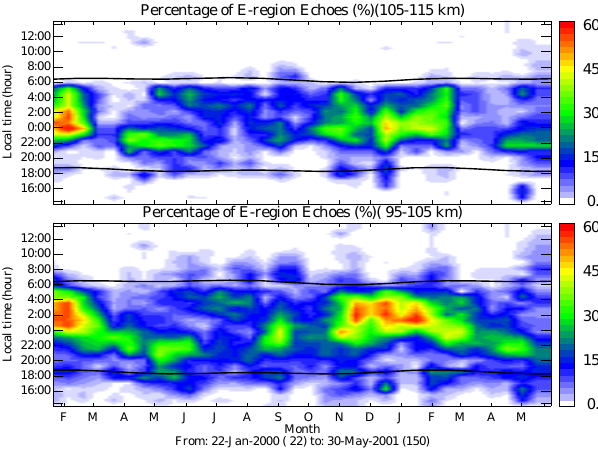
Fig.6. Seasonal variability of the diurnal percentage of occurrence of lower E-region (bottom) and the upper E-region (top) irregular- ities. These statistics have been obtained by processing 15 days at the time. The local sunrise (sunset) times are shown with the upper (lower) black curve on each